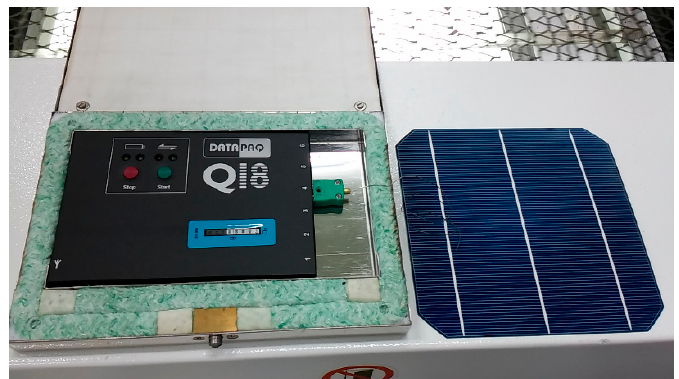
Figure 2. Temperature measurement using data log in drying and firing processes.